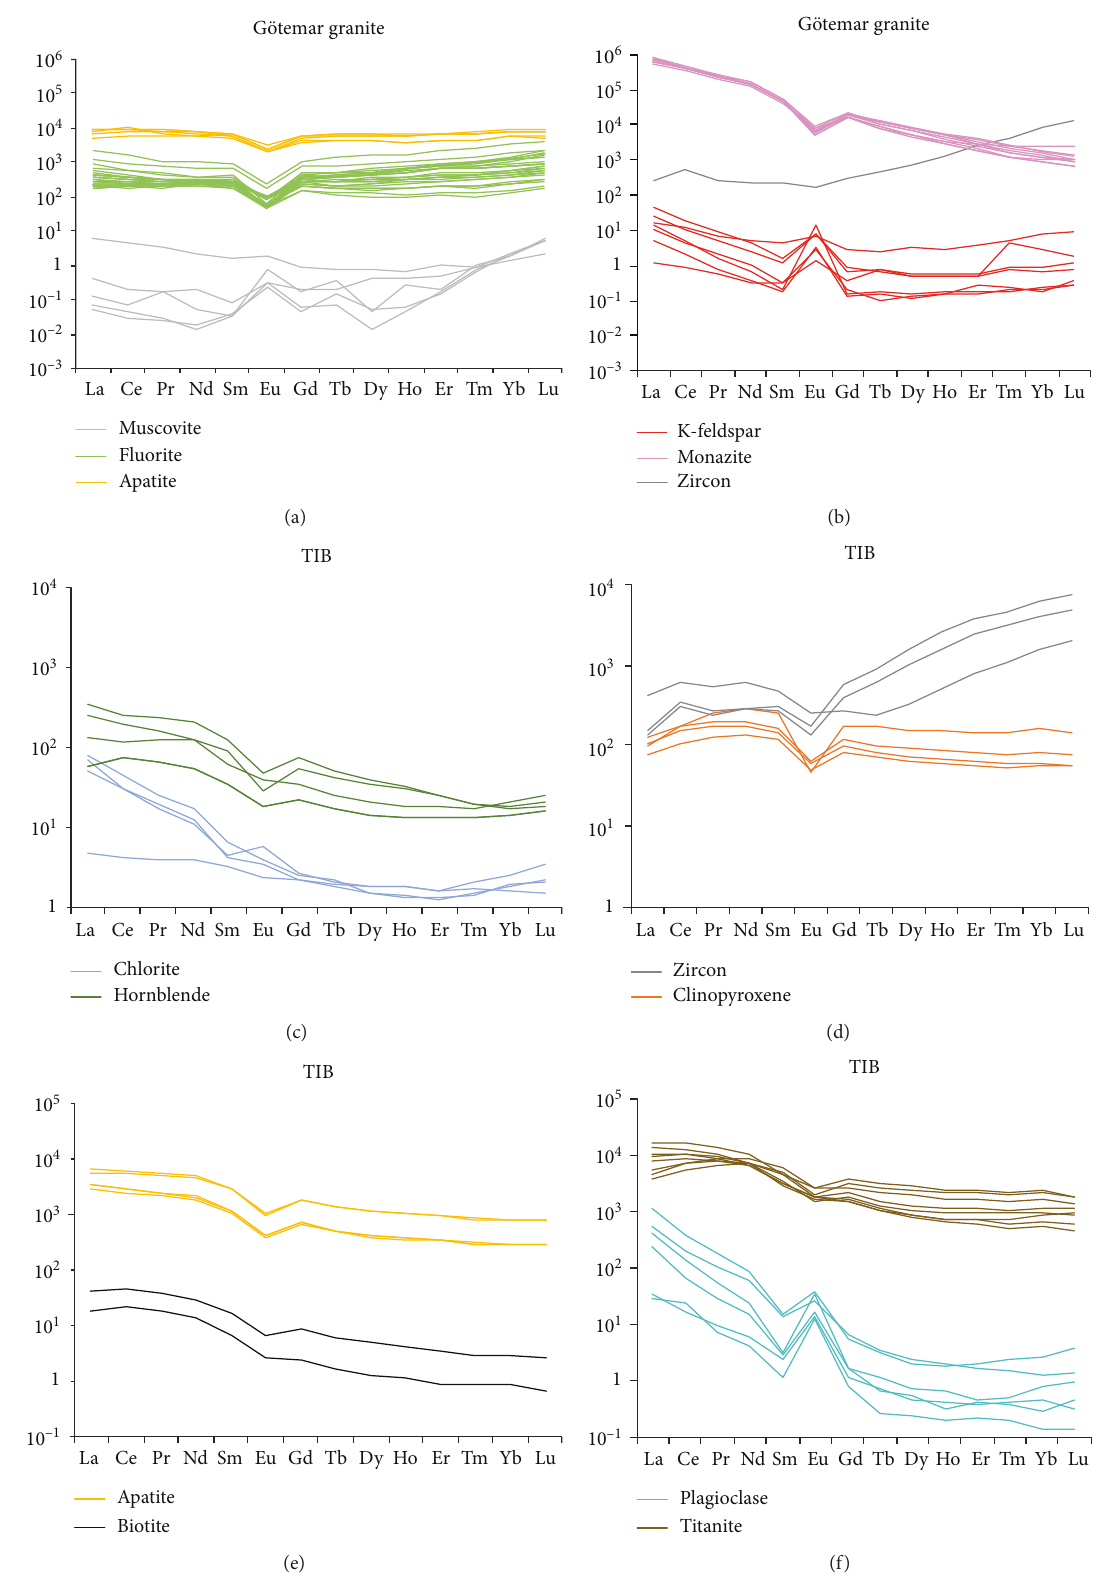
Figure 4: Chondrite-normalized [40] REE concentrations of minerals in (a and b) the Götemar granite and (c – f) the rocks of the Transscandinavian Igneous Belt